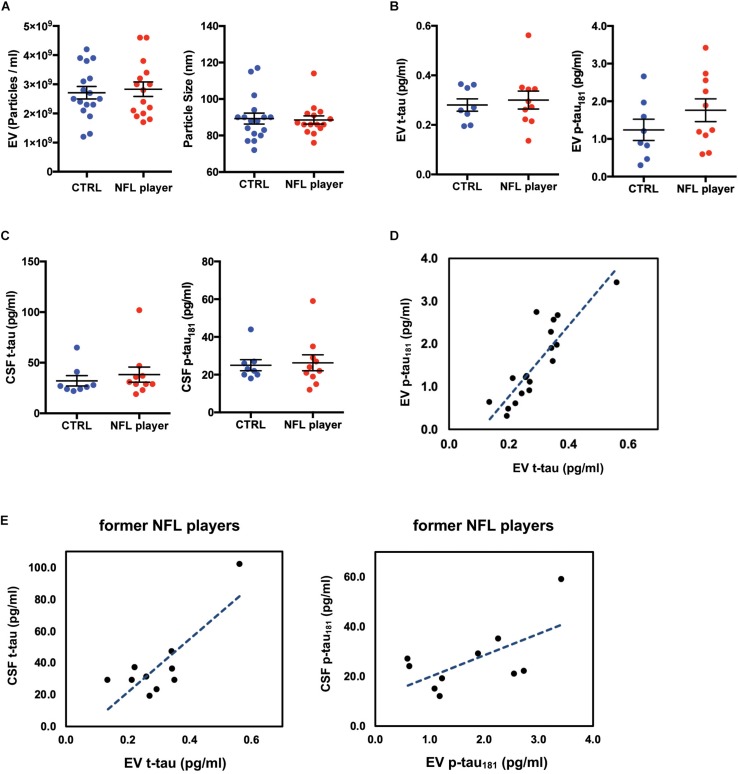
Biochemical characteristic of CSF-derived EVs isolated from former NFL players. (A) Left: Particle numbers of CSF-derived EV fraction from CTRL or former NFL players by Nanoparticle tracking analysis (p = 0.9628 by Mann-Whitney test). Right: Particle size of CSF-derived EV fraction (p = 0.9628). (B) T-tau and p-tau181 levels in CSF-derived EVs by ultrasensitive immunoassay. Left: EV t-tau levels (p = 0.8688). Right: EV p-tau181 levels (p = 0.2682). (C) T-tau and p-tau181 levels in total CSF by multiplex Luminex platform. Left: CSF t-tau (p = 0.3031). Right: CSF p-tau181 (p = 0.9477). (D) Scattered plot of t-tau and p-tau181 in CSF derived EV samples (r = 0.870, p < 0.0001). (E) Left: Scattered plot of t-tau levels in CSF-derived EV and in total CSF in the former NFL players (r = 0.812, p = 0.0044). Right: Scattered plot of p-tau181 levels in CSF-derived EV and in total CSF in the former NFL players (r = 0.627, p = 0.0524).